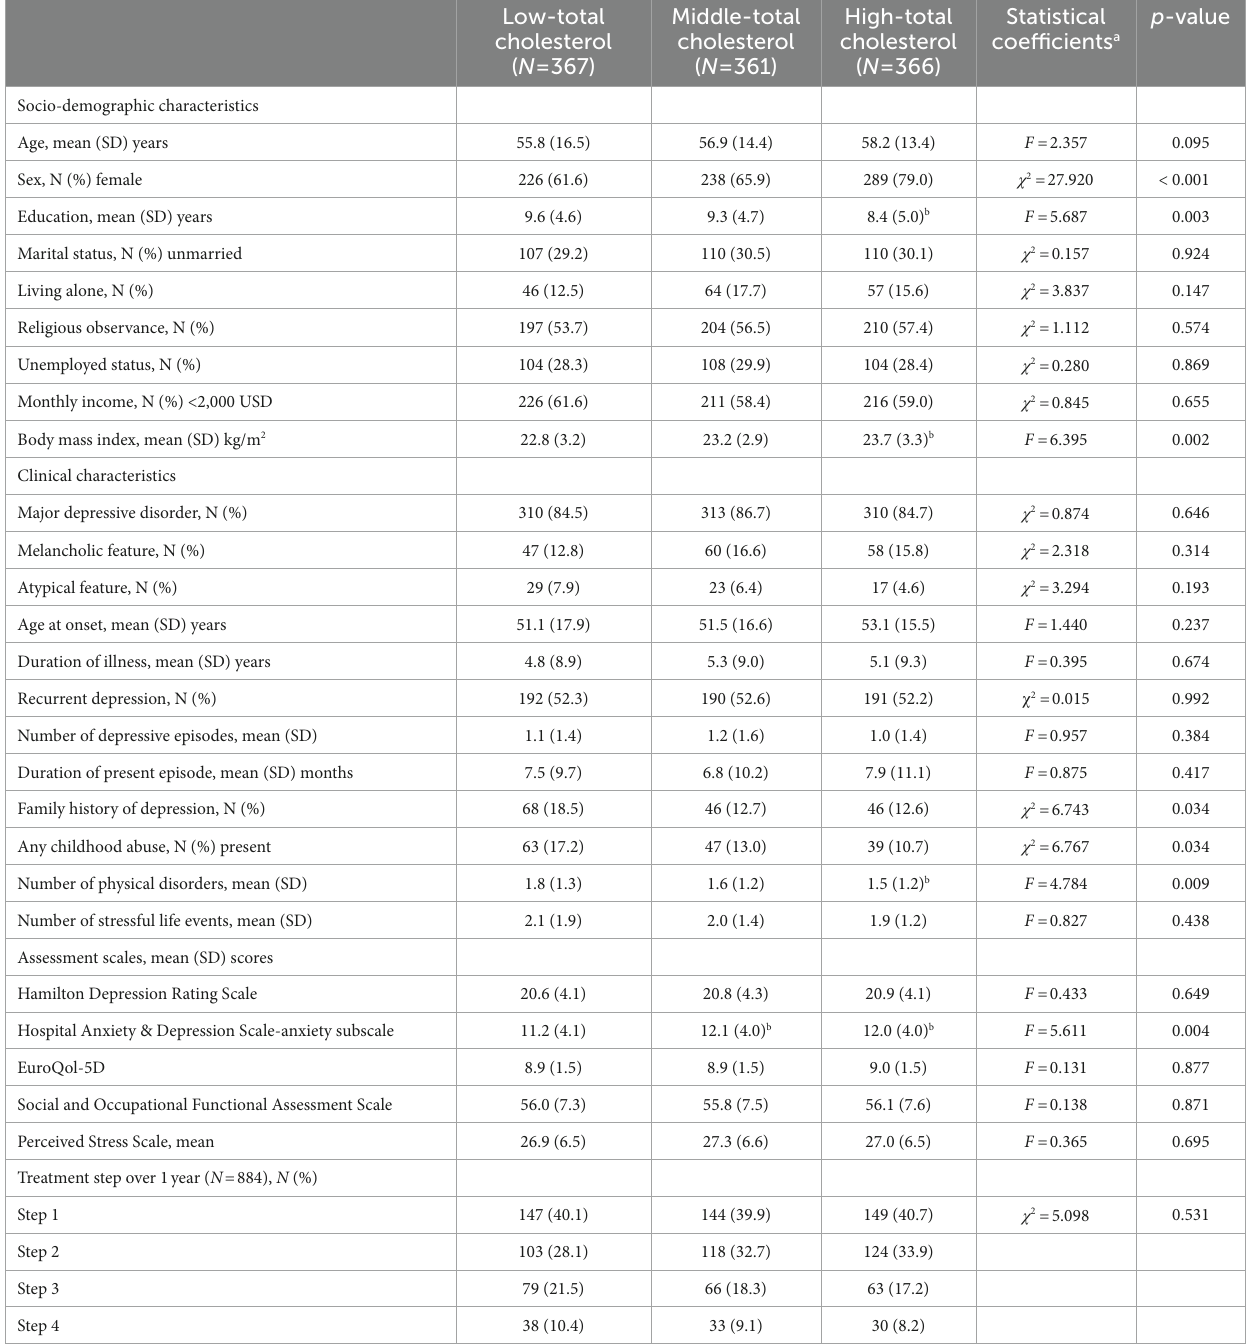
TABLE 1 Baseline characteristics according to serum total cholesterol levels ( N =